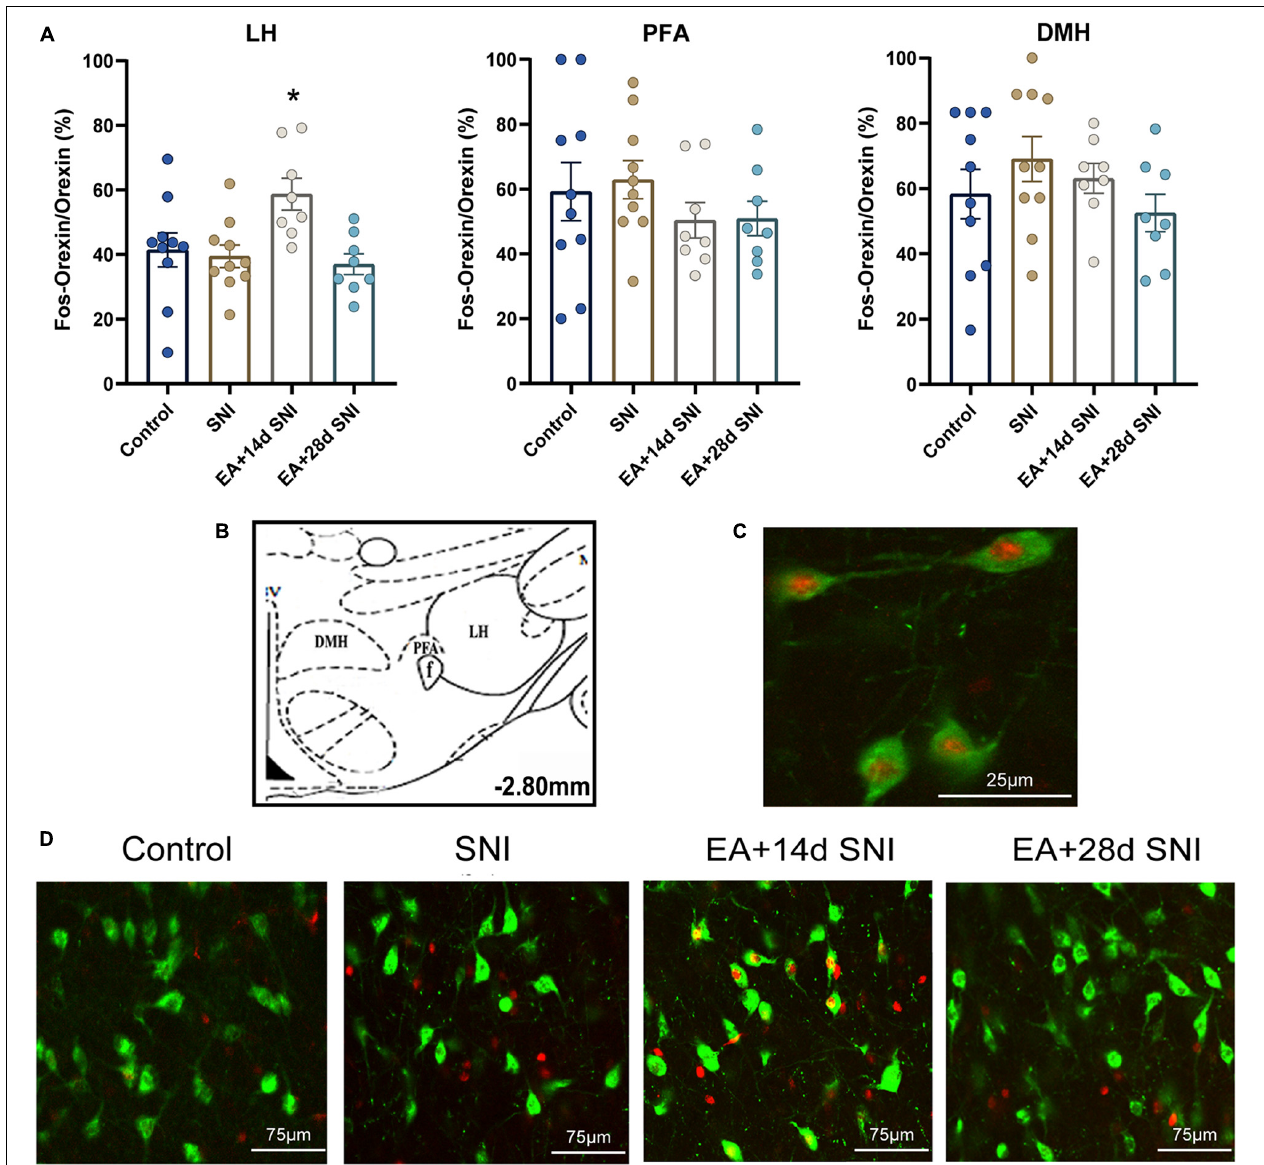
FIGURE 3 | The reward effects of pain relief induced by EA-induced activation of the c-Fos-positive orexin neurons in the LH. (A) The percentages of orexin neurons that were observed to be c-Fos positive in the LH, PFA and DMH. * p < 0.01 vs. SNI group, control group, and EA + 28 days SNI. (B) Schematic coronal section through the hypothalamic subregions where stained nuclei were counted. (C) Double-labeled orexin (green) + c-Fos-positive (red) neurons ( × 40) in the LH. (D) Representative photomicrograph showing orexin/c-Fos immunoreactivity in the LH. Scale bar, 75 µ